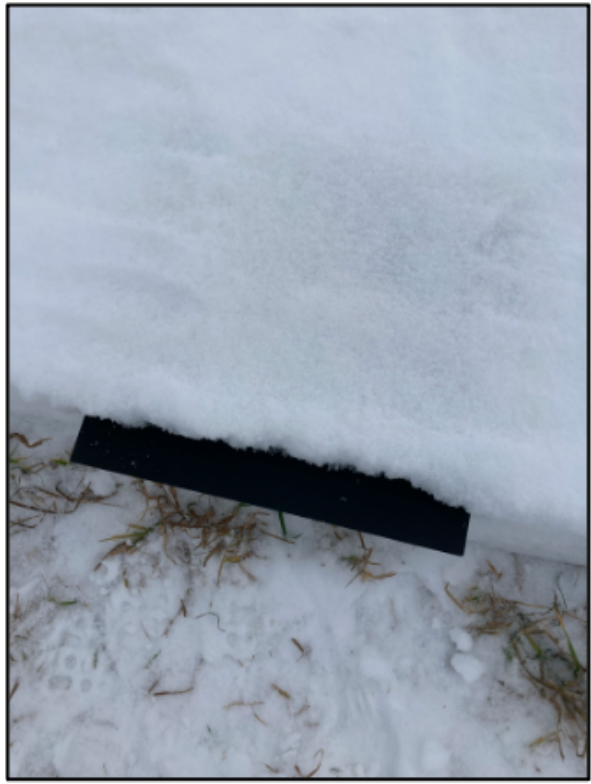
Figure 4. Photograph of the black aluminum panel inserted into the snow pit sidewall approximately 2.5cm from the surface.